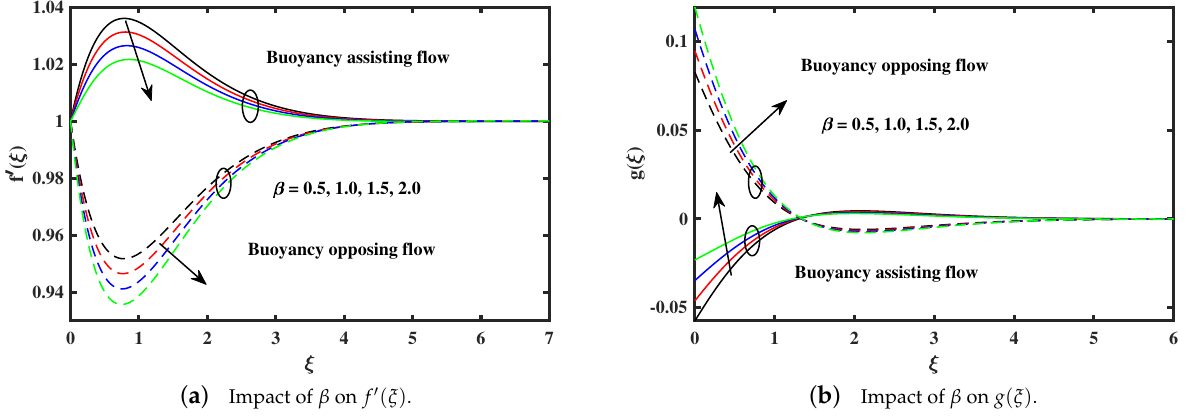
Figure 6. Fluctuation of f (cid:48) ( ξ ) and g ( ξ ) against ferrohydrodynamic interaction ( β ).